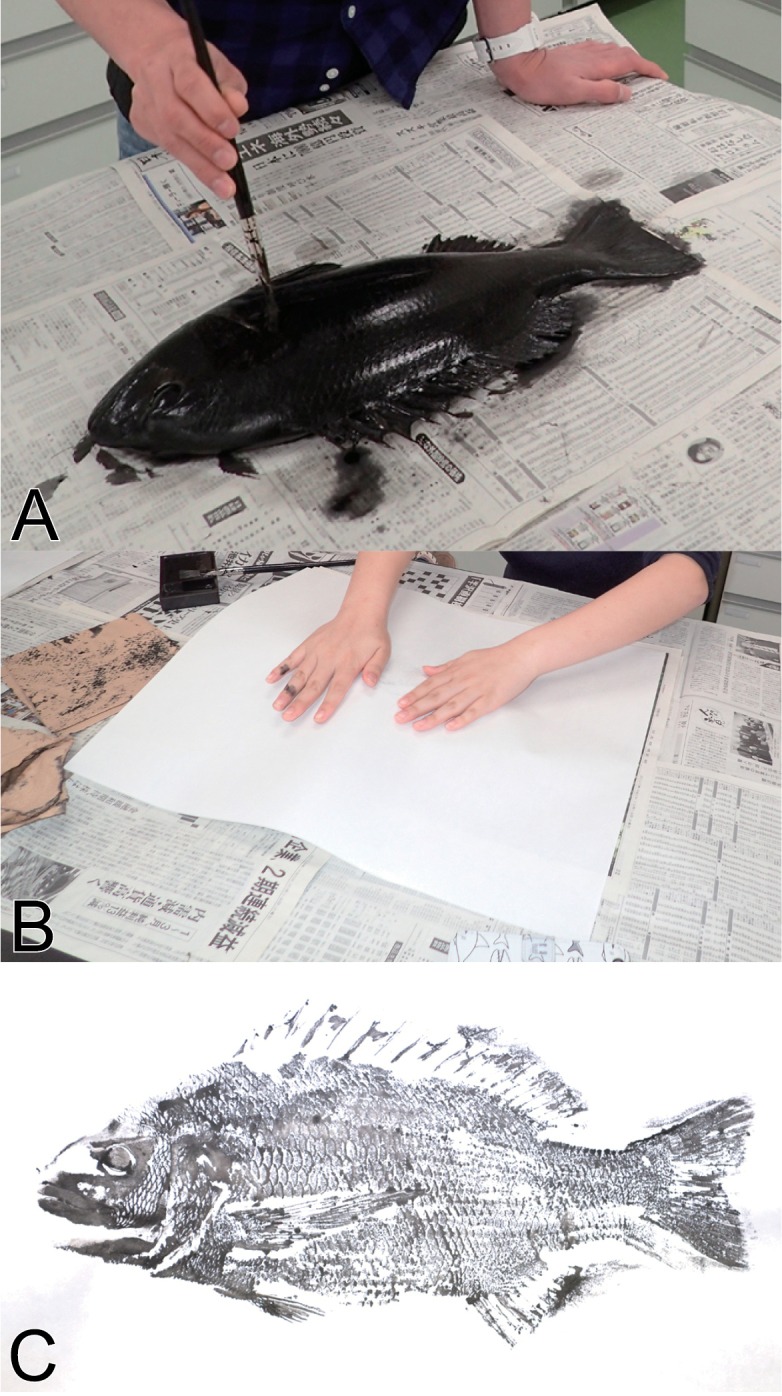
An explanation of fish rubbing (‘gyotaku’, in Japanese). A 1st step – the fish specimen is painted using ink B 2nd step – the specimen is covered with a sheet of paper C the finished image of the fish specimen on the paper. This is known as the direct method of ‘gyotaku’; there is also an indirect method whereby a sheet of paper is placed on the fish specimen, then the sheet is painted by hand using ink. See also Hiyama (1964a, b) and Shimizu (1972, 1975).